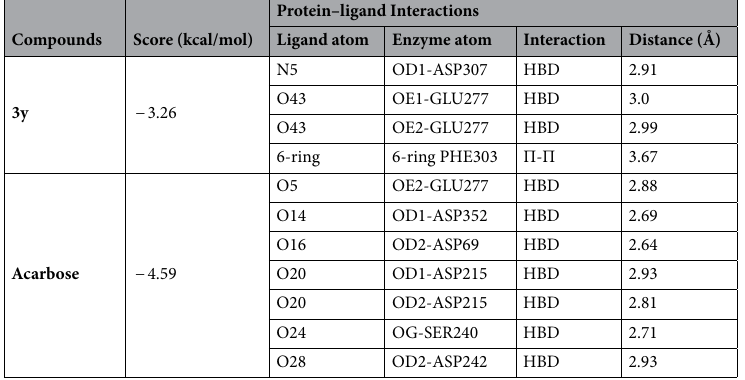
Table 2. The docking results of compounds 3a–3y